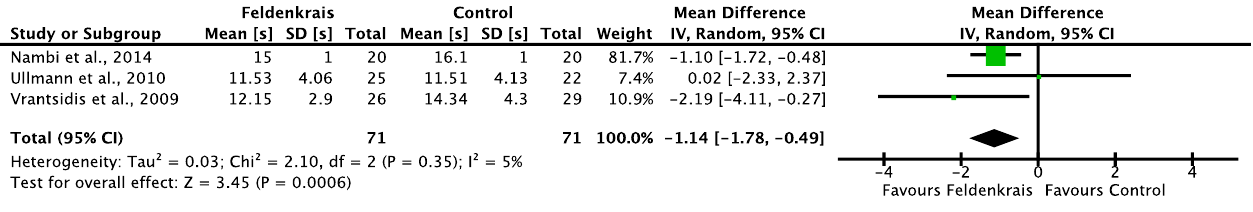
Figure 2. Meta-analysis of TUG in elderly subjects measured in seconds. (Nambi et al. [24], Ullmann et al. [20], Vrantsidis et al. [17]). Ullmann et al. [20], Vrantsidis et al.